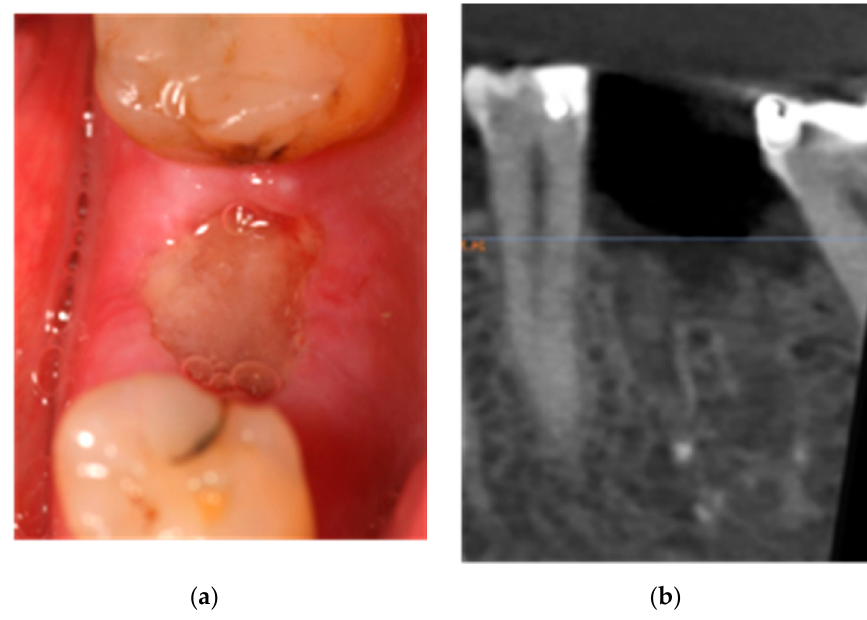
Figure 1. ( a ) Clinical aspect of the injury. ( b ) X-ray of the affected area.